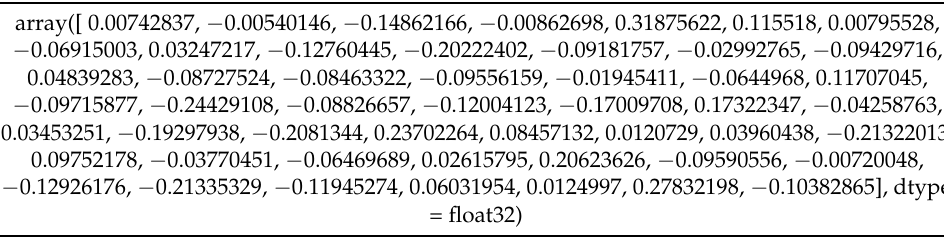
Table 19. The vector for first product (cid:126) a ( p 1 )